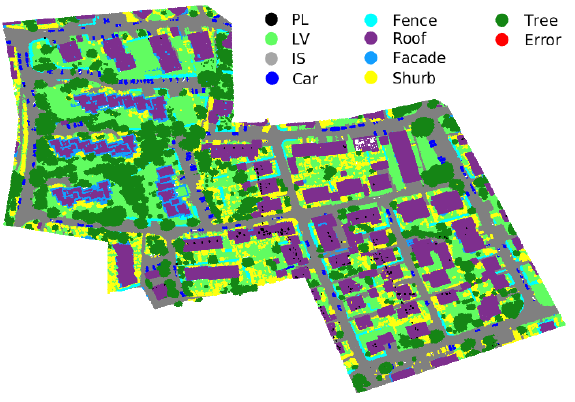
Figure 2. Bar diagrams of the point distribution of the Vaihingen training and test datasets.